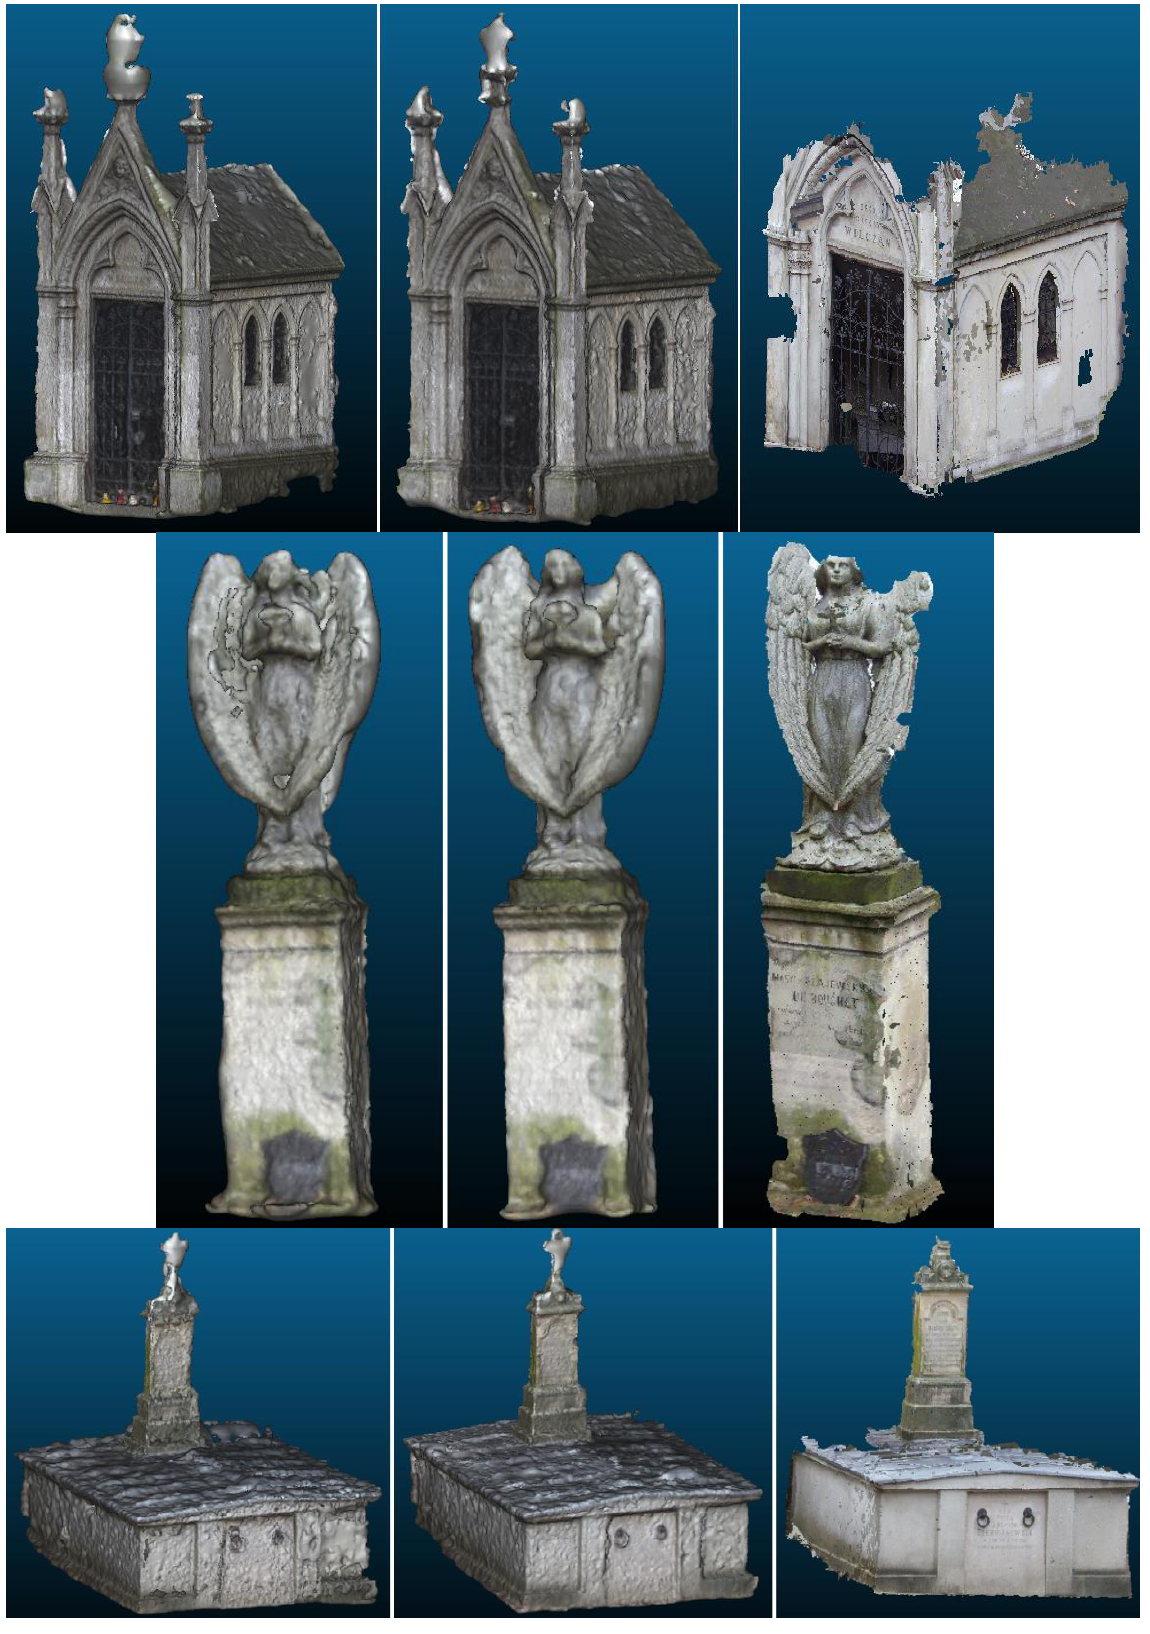
Figure 5. Resulting 3d textured models: left column: VisualSFM/CloudCompare, middle column: OSM Bundler/CloudCompare, right column: